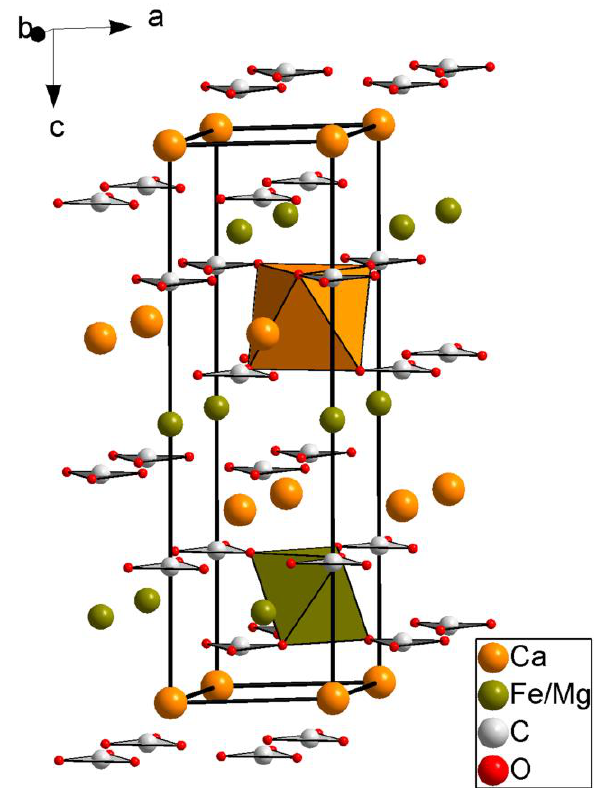
Figure 1. Iron-rich R - 3 ̅ ankerite structure under ambient conditions. Triangular [CO 3 ], and octahedral (CaO 6 ) and ((Fe/Mg)O 6 ) units are colored light gray, orange, and green, respectively, as with the central atoms. The O atoms are colored in red. The unit cell is depicted by a solid black line.